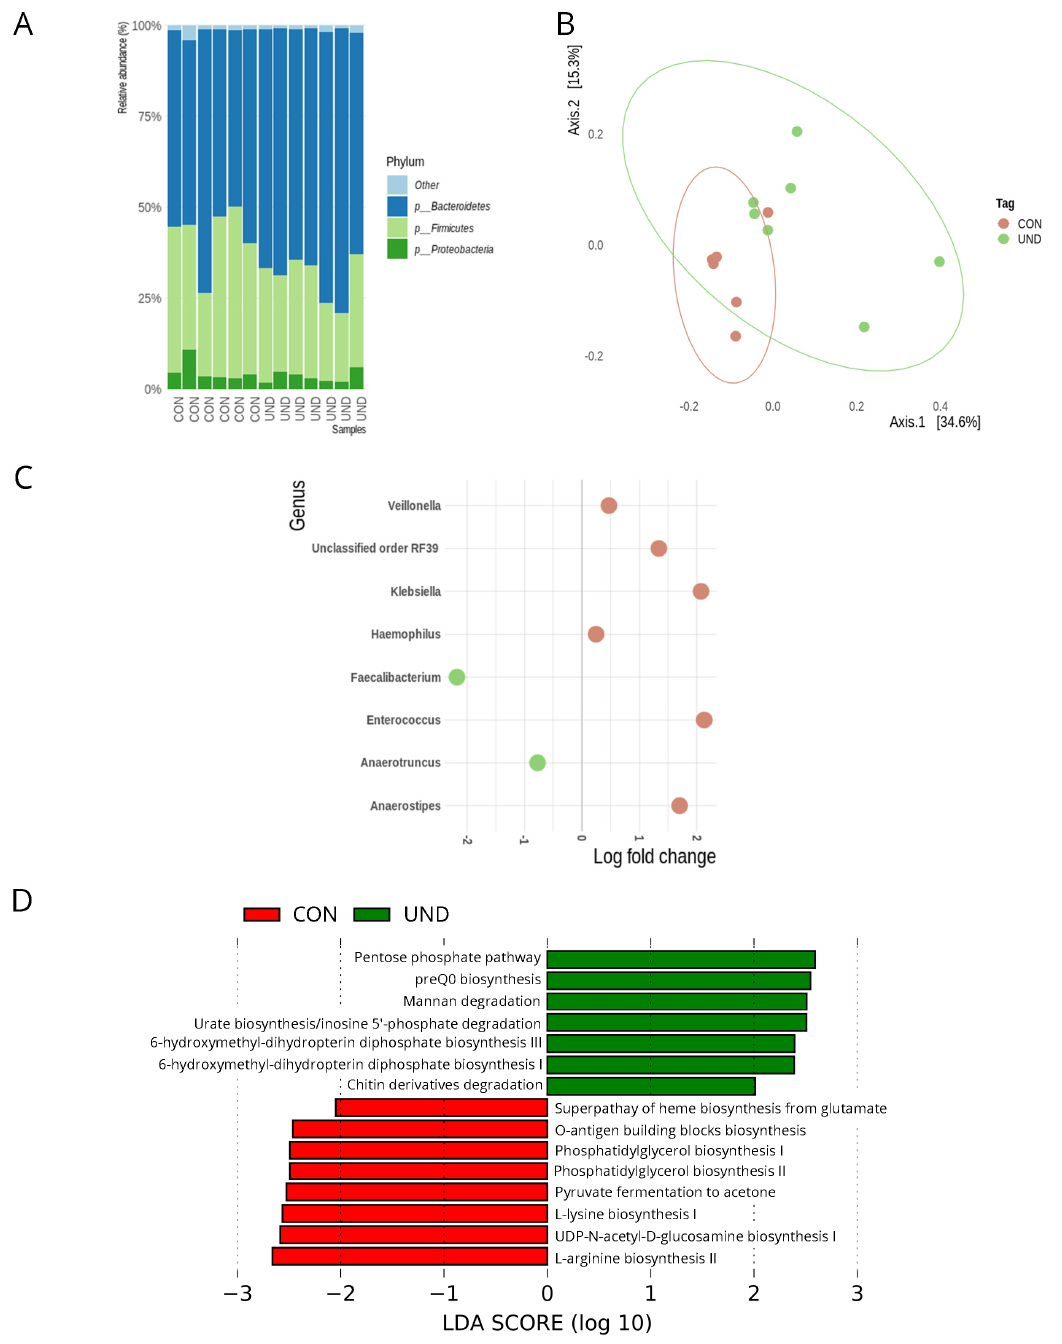
Figure 2. The gut microbiota composition and inferred functional content of gut microbiota between of control (CON) and undernourished (UND) C57BL/6 mice. ( A ) Relative abundance at the phylum level for groups of CON (n = 6) and UND (n = 7) C57BL/6 mice; ( B ) Principal coordinate analysis (PCoA) of Bray–Curtis distances among groups of CON (n = 6) and UND (n = 7) C57BL/6 mice. Each point corresponds to a community from a single mouse. Colors indicate group identity. Ellipses show the 95% confidence intervals. Intra-group differences were evaluated using ADONIS test ( p < 0.05); ( C ) ANCOM-BC log fold change showing differentially abundant taxonomic clades in the gut microbiota of UND (n = 7) versus CON (n = 6) C57BL/6 mice; ( D ) LEfSe LDA scores showing significant pathway differences between CON (n = 6) and UND (n = 7) C57BL/6 mice of PICRUSt predicted the relative MetaCyc pathways abundances. Significant differences between groups were corrected with Benjamini–Hochberg False Discovery Rate p FDR < 0.05.